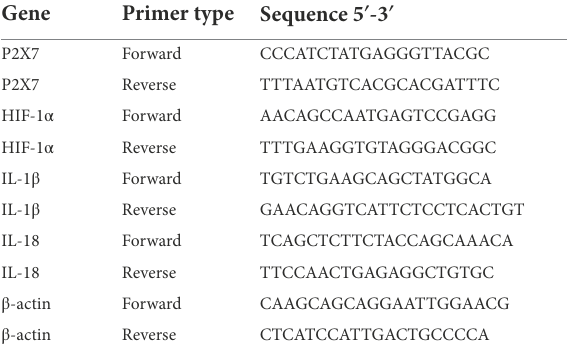
TABLE 1 Sequences of the primers for Quantitative real-time